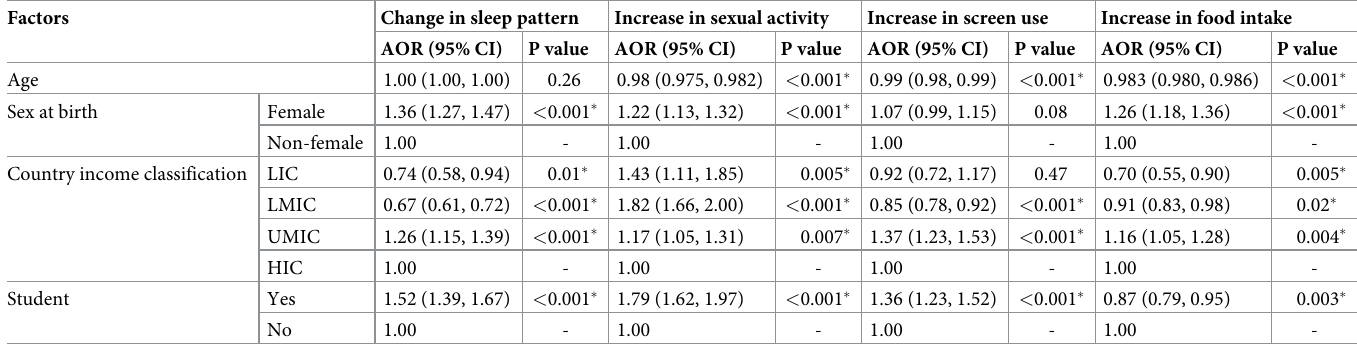
Table 2. Change in personal behaviors reported by students during the pandemic controlling for sex, age and income level of country of residence (N = 13,116).